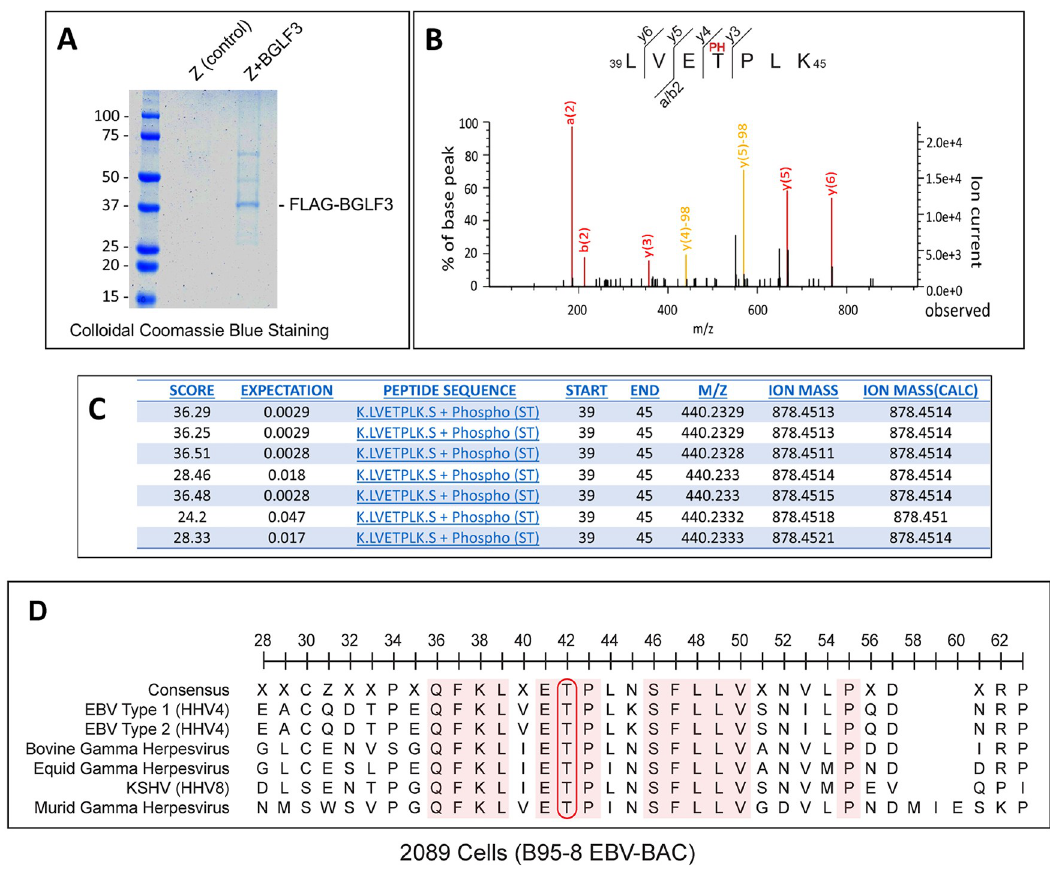
Fig 1. Identification of BGLF3 threonine 42 as a phosphoacceptor site. EBV positive 2089 cells were transfected with ZEBRA or ZEBRA plus FLAG-tagged BGLF3. Cells were harvested after 48h and cell lysates were subjected to immunoprecipitation (IP) using agarose beads coated with anti-FLAG antibody. Immunoprecipitated BGLF3 and associated proteins were eluted using 3X FLAG peptide. (A) Twenty percent of the eluted proteins was resolved on 10% SDS-PAGE and stained with colloidal Coomassie Blue. The remaining 80% was digested with trypsin and subjected to phosphoenrichment followed by LC-MS/MS. (B) A representative MS/MS spectrum of the BGLF3 peptide spanning amino acids 39 to 45 and its observed fragmentation pattern. (C) A table summarizing detection of the 39 to 45 phosphopeptide present in BGLF3 in seven independent experiments. (D) Sequence alignment of the region encompassing T42 in BGLF3 and related orthologs in other gamma herpesviruses.